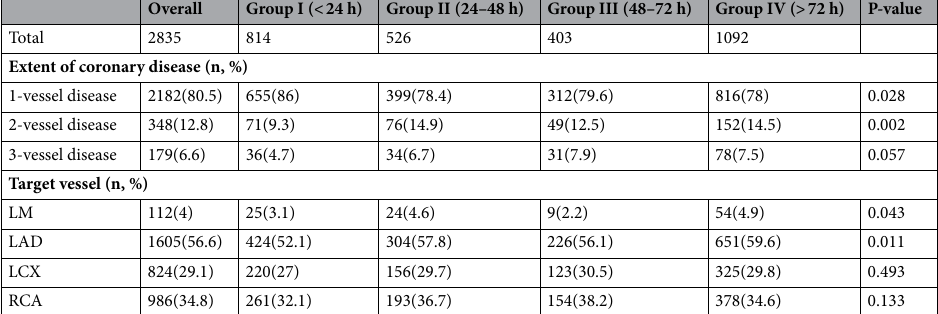
Table 2. Coronary angiographic characteristics. LM left main coronary artery, LAD left anterior descending, LCX left circumflex artery, RCA right coronary